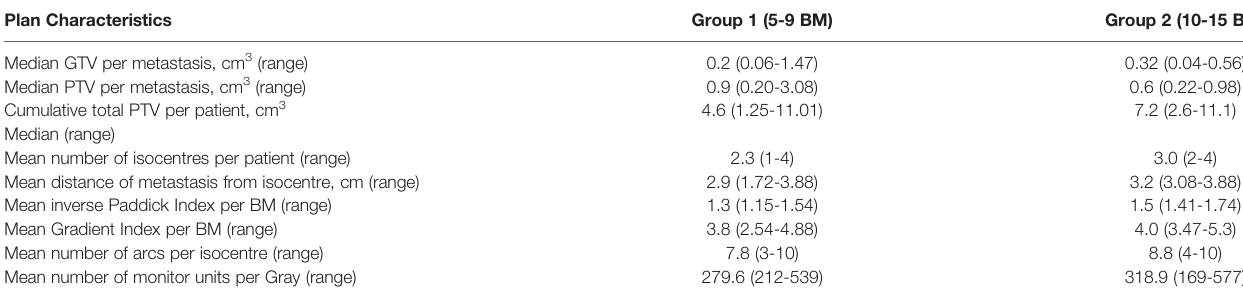
TABLE 2 | Dosimetric features of SRS plans for multiple metastases.